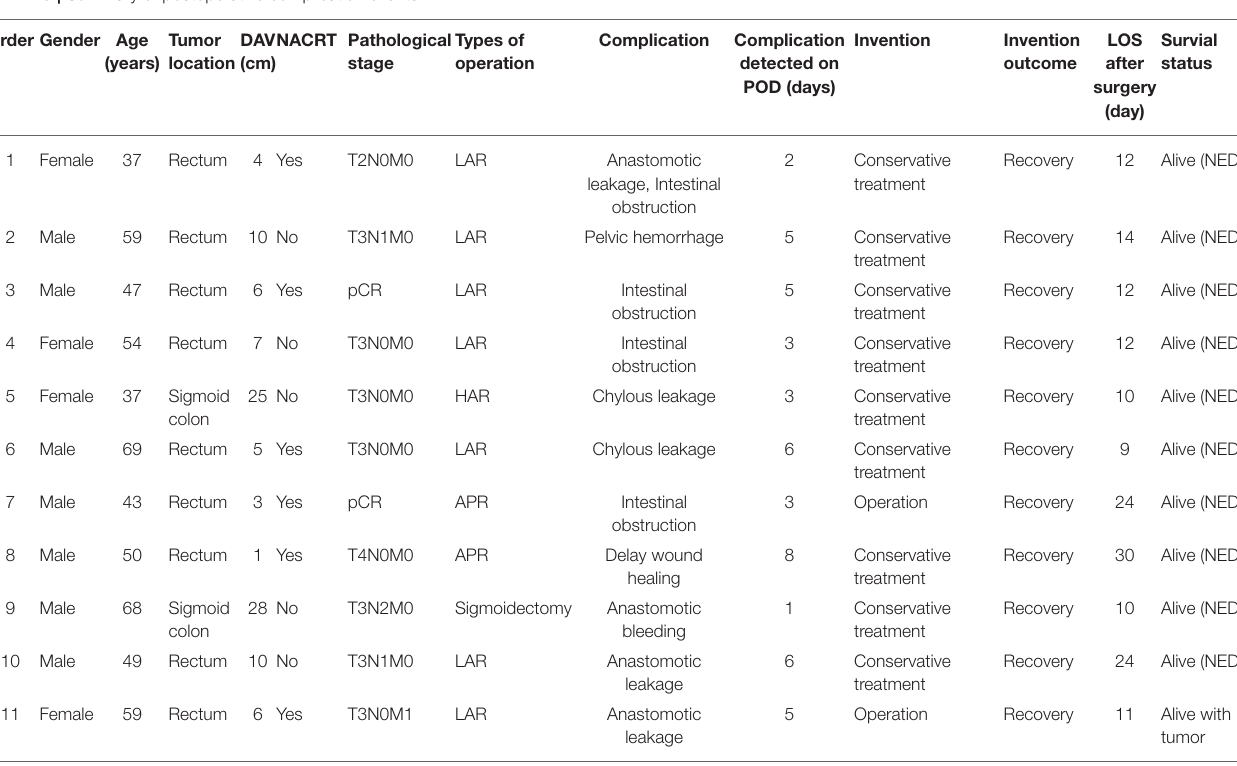
TABLE 5 | Summary of postoperative complication